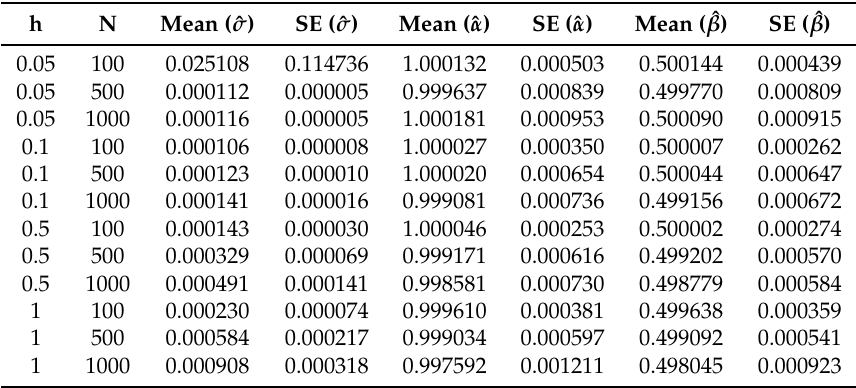
Table 4. Mean and standard error of the